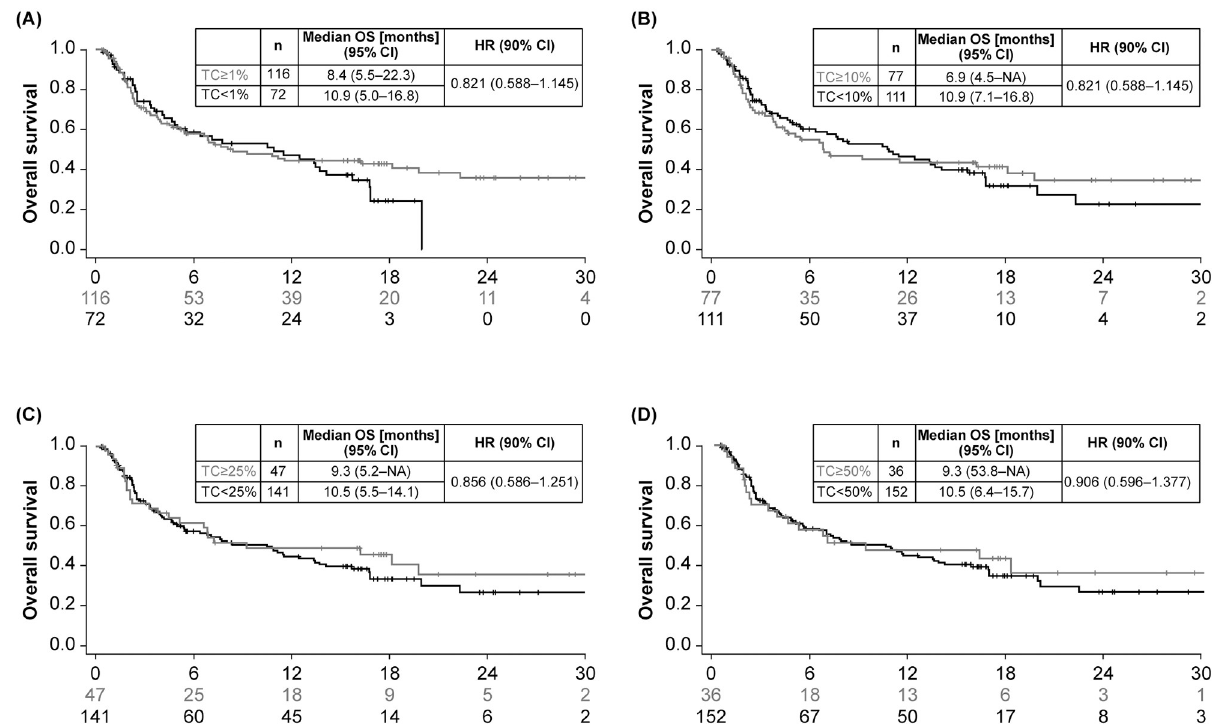
Fig 2. Overall survival in Study 1108 at different cutoffs for PD-L1 expression in tumor cells (TC) with cutoffs of � 1% (A), � 10% (B), � 25% (C), and � 50% (D). CI, confidence interval; HR, hazard ratio; NA, not applicable; OS, overall survival; PD-L1, programmed death ligand-1; TC, tumor